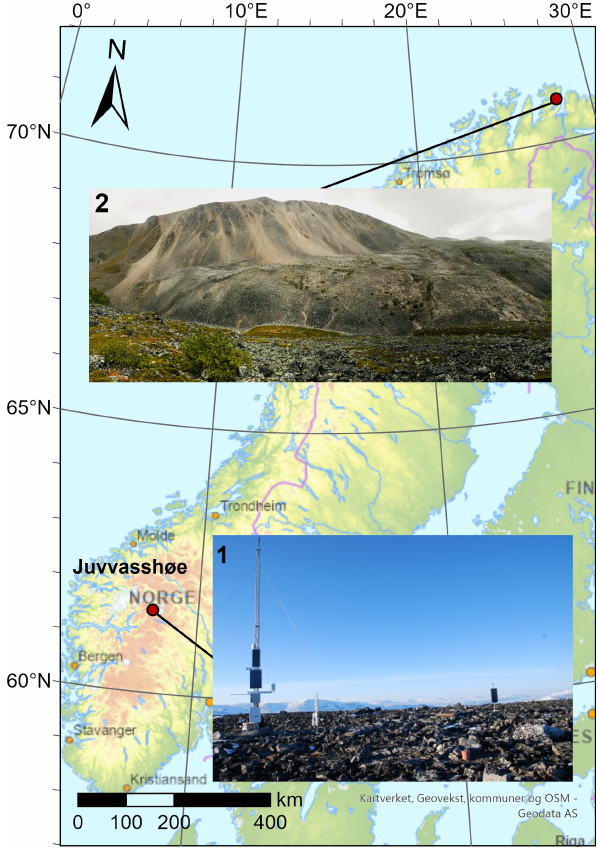
Figure 1. Location of the two sites in Norway (© Norwegian Map- ping Authority). (1) Blockfield at Juvvasshøe (1894ma.s.l.), (2) rock glacier at Ivarsfjorden (60–160ma.s.l.).